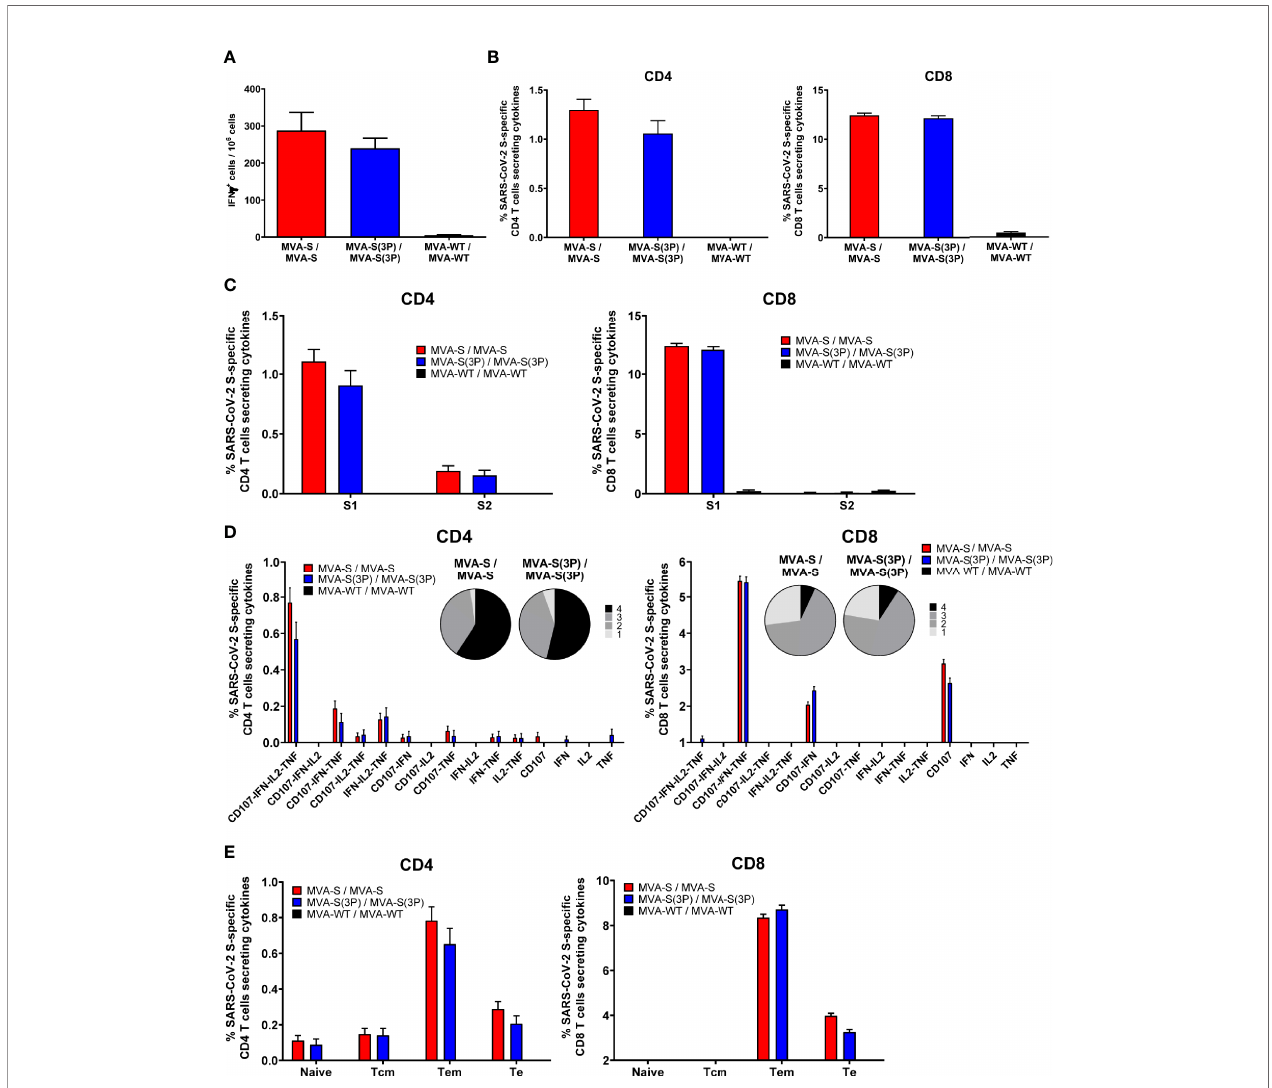
FIGURE 3 | SARS-CoV-2 S-speci fi c T-cell immune responses elicited in C57BL/6 immunized mice. (A) Magnitude of SARS-CoV-2 S-speci fi c cell responses. Cells secreting IFN- g per million of splenocytes and directed against S1 + S2 peptide pools in C57BL/6 immunized mice were evaluated at 10 days post-boost by an ELISpot assay from a pool of splenocytes derived from 6 immunized mice per group. Mean values and SEM of triplicate samples. (B) Magnitude of S-speci fi c CD4 + and CD8 + T-cell immune responses evaluated at 10 days post-boost. Percentages of CD4 + or CD8 + T cells expressing CD107a and/or producing IFN- g and/or TNF- a and/or IL-2 against a mixture of S1 and S2 peptide pools in immunized mice. Cell percentages were determined by ICS from splenocyte pools. (C) S-speci fi c T- cell immune responses against S1 and S2 regions. Percentages of S1- or S2-speci fi c CD4 + and CD8 + T cells determined as in panel (B) . (D) Polyfunctional pro fi les (based on expression of selected markers CD107a, IFN- g , TNF- a and IL-2) of total S-speci fi c CD4 + or CD8 + T-cell immune responses directed against a mixture of S1 and S2 peptide pools. The pie charts summarize the percentage of S-speci fi c T cells exhibiting 1, 2, 3, or 4 markers. (E) Percentages of Naïve (CD127 - /CD62L - ), T central memory (Tcm, CD127 + /CD62L + ), T effector memory (Tem, CD127 + /CD62L ⁻ ), and T effector (Te, CD127 ⁻ /CD62L ⁻ ) CD4 + and CD8 + T cells speci fi c for S1 and S2 peptide pools, and expressing any of the markers CD107a, IFN- g , TNF- a , and